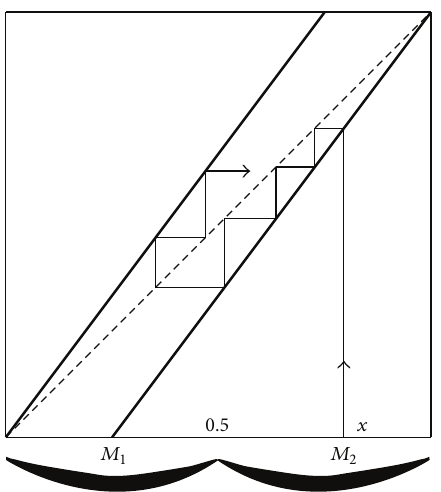
Figure 7: Example of masked dynamical system for IFS equation (26), 𝑀 1 = [0,0.5) , 𝑀 2 = [0.5,1] , and 𝜏(𝑥) = 222211 .. . .